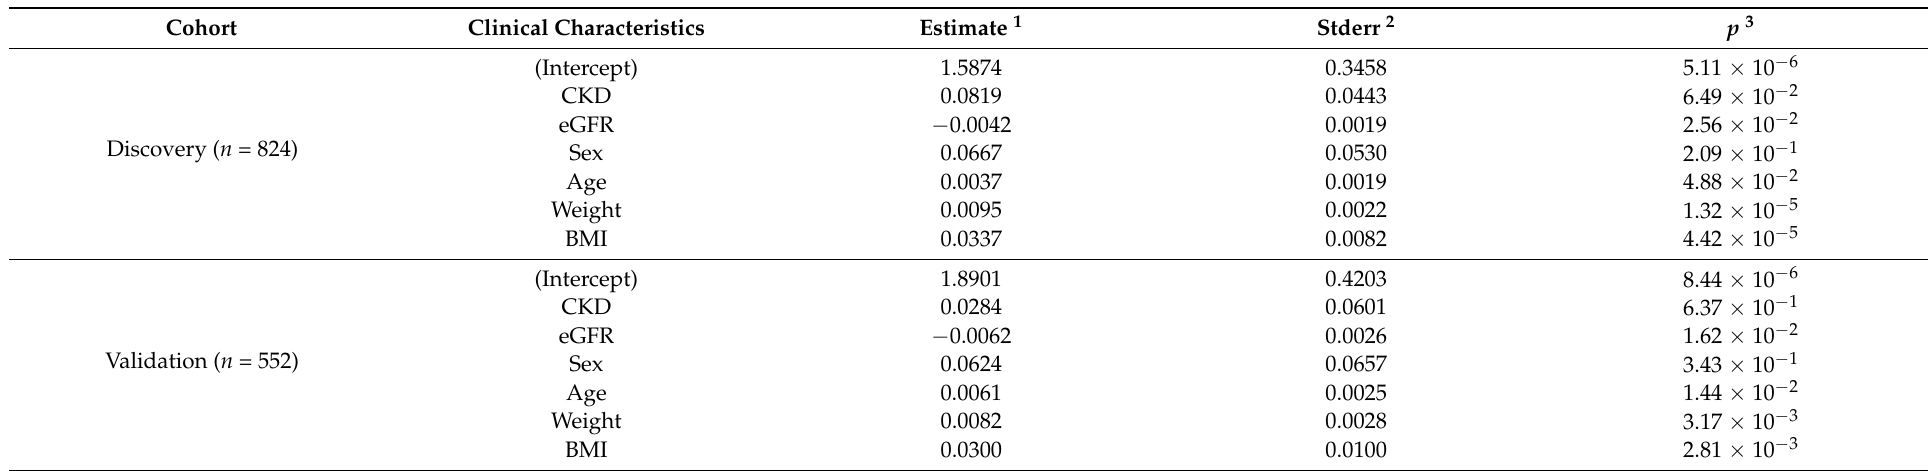
Table 2. Associations between clinical characteristics and blood